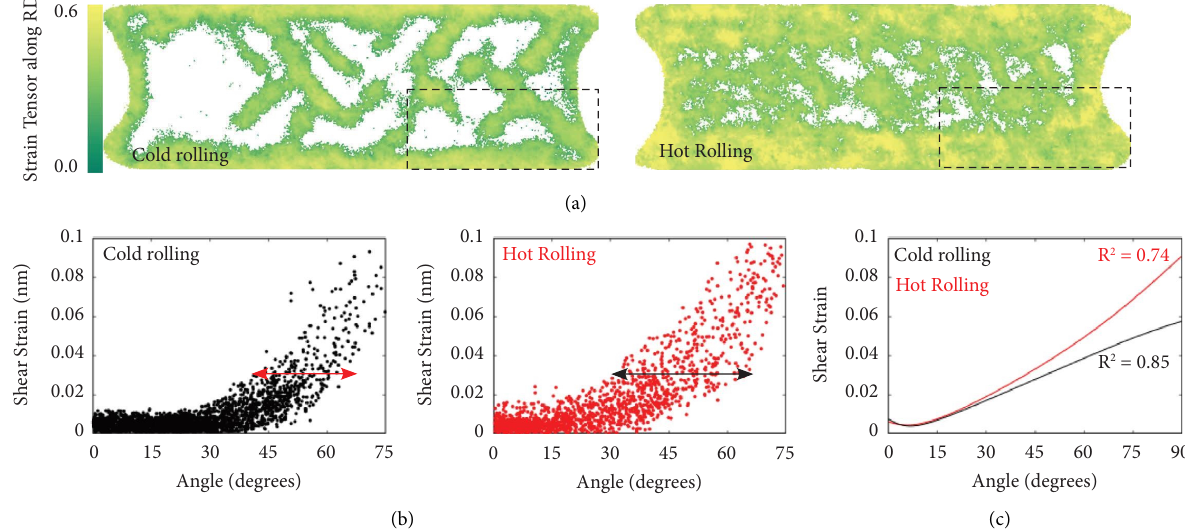
Figure 4: (a) Strain tensor snapshots of the rolled samples under cold-and hot rolling conditions, (b) shear strain as a function of displacement angle, (c) polynomial ftting of the plots given in part